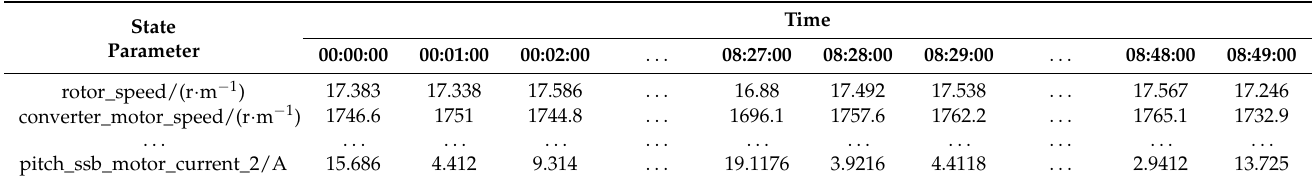
Table 3. Partial operation data of fan No. A16 on 1 February 2021.